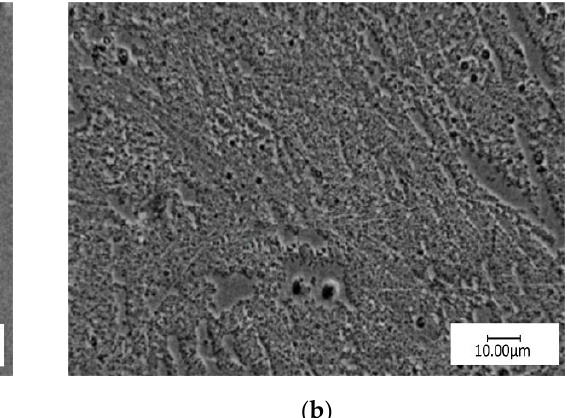
Table 10. The results of the wear test